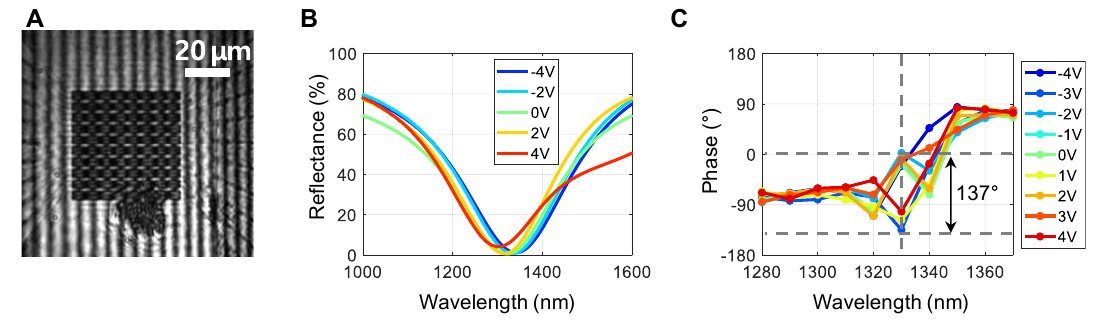
Figure 4: Experimental measurement of the reflection phase. (A) Captured fringe pattern in the Michelson interferometer. (B) Reflectance of the device with the applied bias from − 4 V to + 4 V with the step sizeof2V.(C)Re fl ectionphasespectrumoffabricateddeviceasafunctionofthewavelengthrangingfrom1280to1370nmfortheappliedbias from − 4 V to + 4 V with the step size of 1 V, showing the phase change up to 137 °